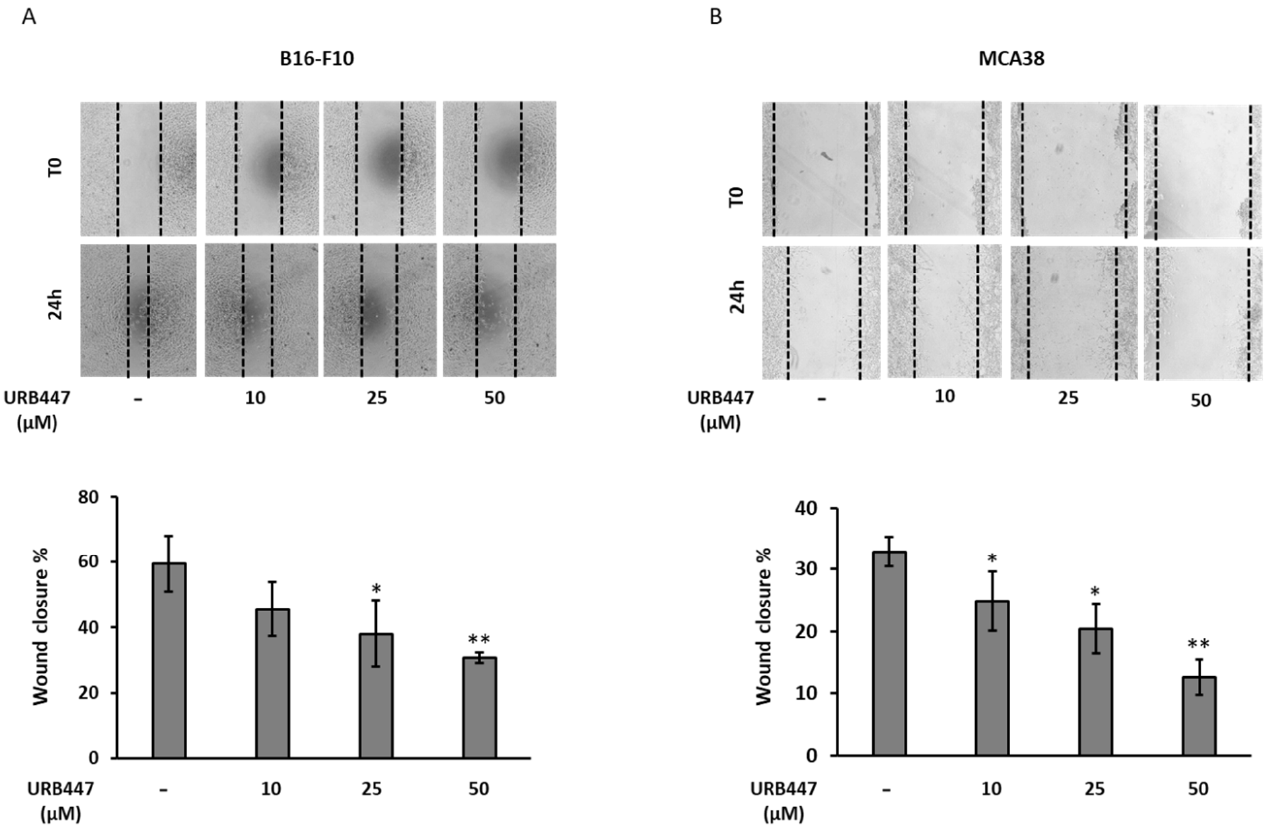
Figure 5. The migratory ability of tumor cells upon URB447 treatment. Wound healing assay was carried out upon stimulation of melanoma ( A ) and CRC cancer cells ( B ) in the presence of increasing concentrations of URB447 for 24 h. The closed wound area was calculated. Images show representative result ( n = 3). Differences were considered statistically significant for * p < 0.05, ** p < 0.01 using Student t test.